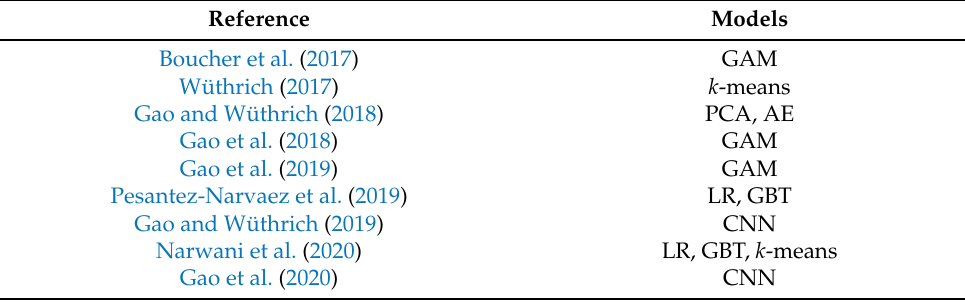
Table 3. Summary of contributions in telematics